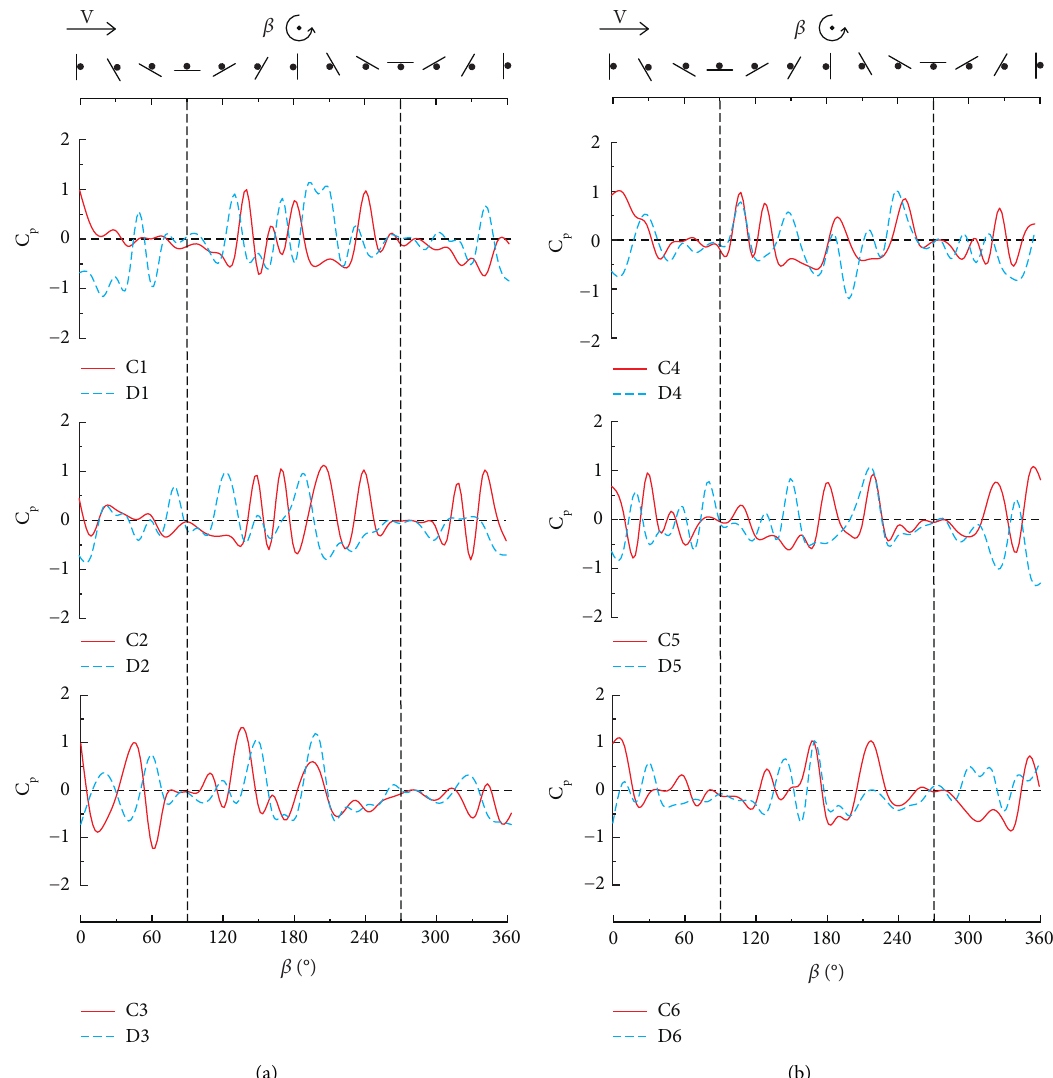
Figure 20: Pressure coefficients of the surface monitoring points with respect to azimuth angle when the porous plate antenna is stationary, β � 0–360 ° , and Δ � 10 ° . (a) Monitoring points 1, 2, and 3; (b) monitoring points 4, 5, and 6 (C represents the front of the antenna and D represents the back of the